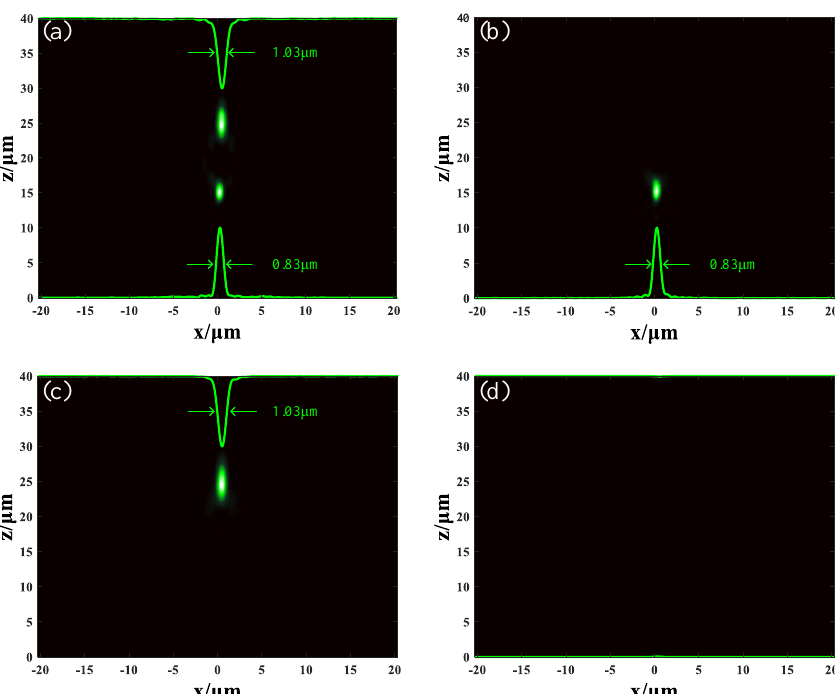
Figure 5. The light field distribution of metalens M 2 . ( a ) The GST in both sections are in amorphous state. ( b ) The GST in section A stays in amorphous state, but the GST in section B stays in crystalline state. ( c ) The GST in section A stays in crystalline state, but the GST in section B stays in amorphous state. ( d ) The GST in both sections are in crystalline state.